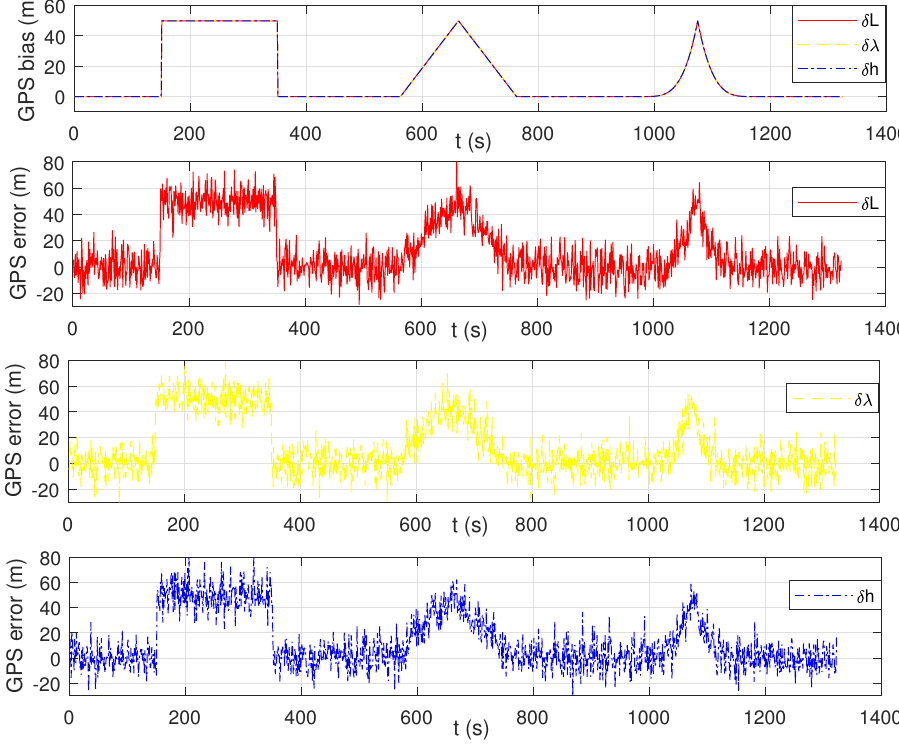
Figure 7. Position error and bias generated by GPS simulator.